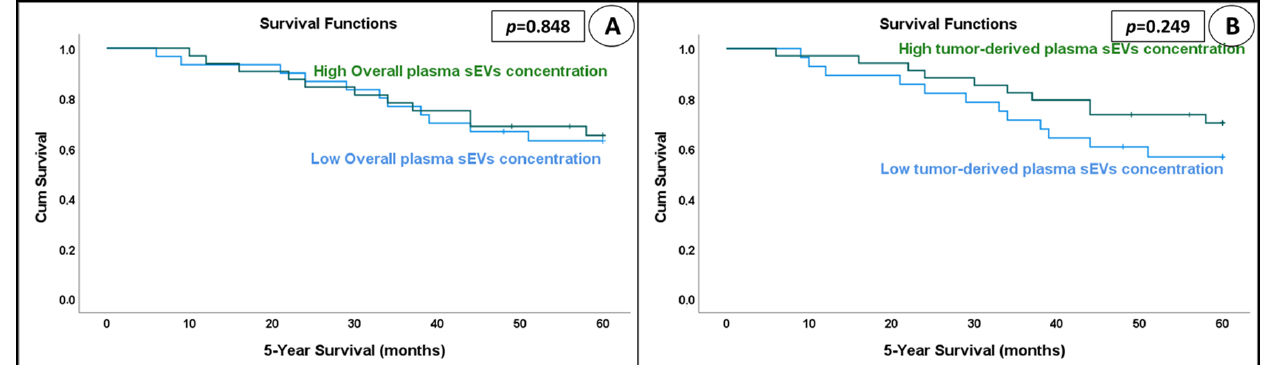
Figure 7. Kaplan Meier curves for 5 ‐ year overall survival of overall sEVs plasma concentrations ( A ) and of tumor ‐ derived plasma sEVs concentrations ( B ) using median as cutoff point (n = 65). No statistically significant differences were observed between 5 ‐ year survival and plasma sEVs concentration, although there was a trend for patients with higher tumor ‐ derived plasma sEVs concentration having longer survival.